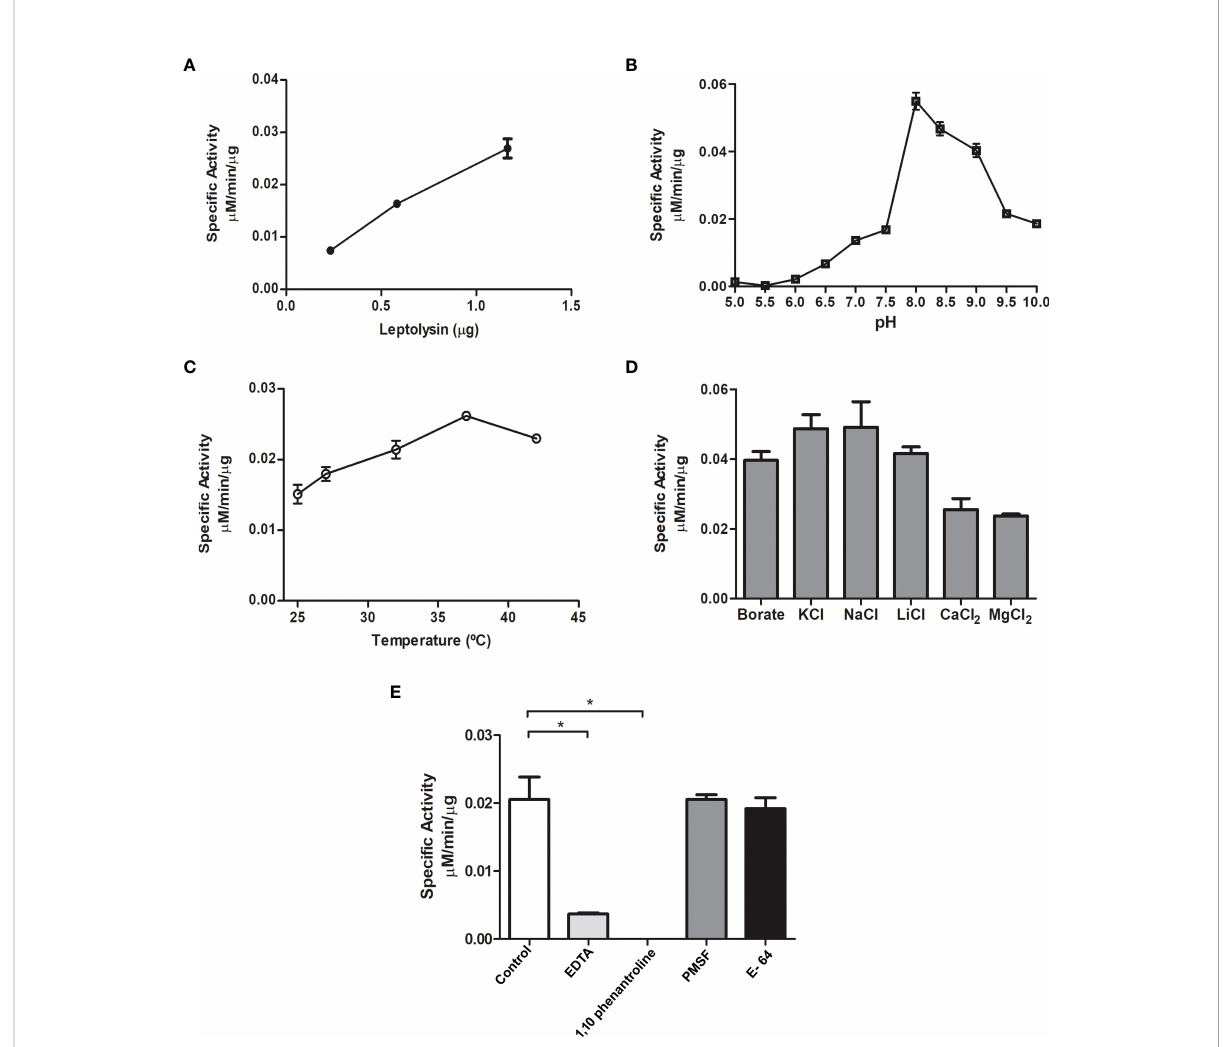
FIGURE 5 Initial biochemical characterization of L. interrogans leptolysin using the Abz-GLARSNL-EDDnp peptide (5 m M) as substrate. (A) Dose-response curve using three different leptolysin amounts (0.3 µg, 0.6 µg and 1.2 µg); (B) Evaluation of optimum pH (pH 5 to pH 10); (C) Thermo-stability study between 25 °C and 42 °C; (D) In fl uence of monovalent and divalent cations on leptolysin activity; (E) Effect of site-directed inhibitors on leptolysin catalytic activity. All assays were made in triplicate and data are presented as mean ± SD The results on the in fl uence of salts (D) and site-directed inhibitors (E) on the proteolytic activity of leptolysin were analyzed using one-way analysis of variance (ANOVA) for between- groups comparisons followed by a Tukey ’ s post-hoc test for multiple comparisons (* p < 0.05).